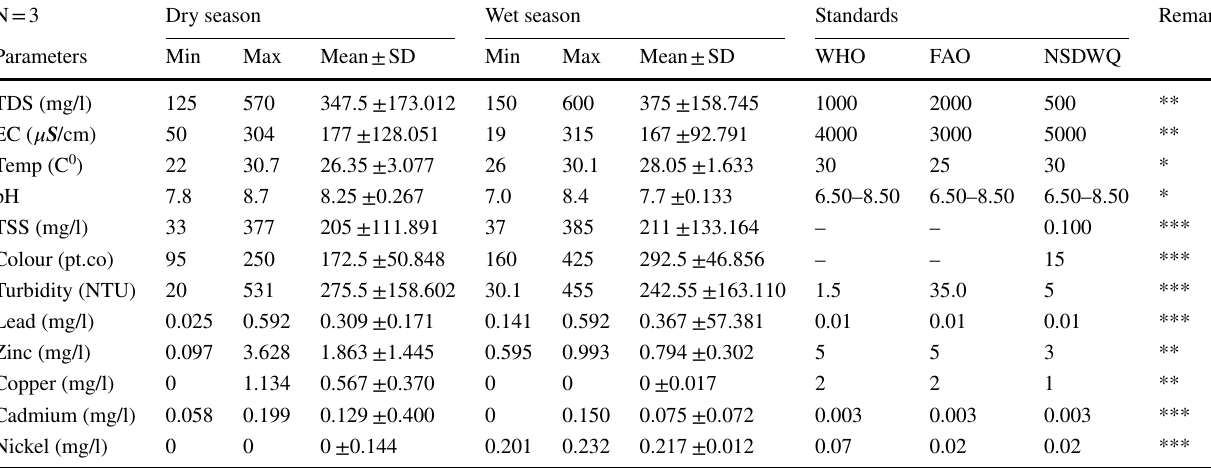
Table 2 Descriptive statistics of physico-chemical parameters of River Benue